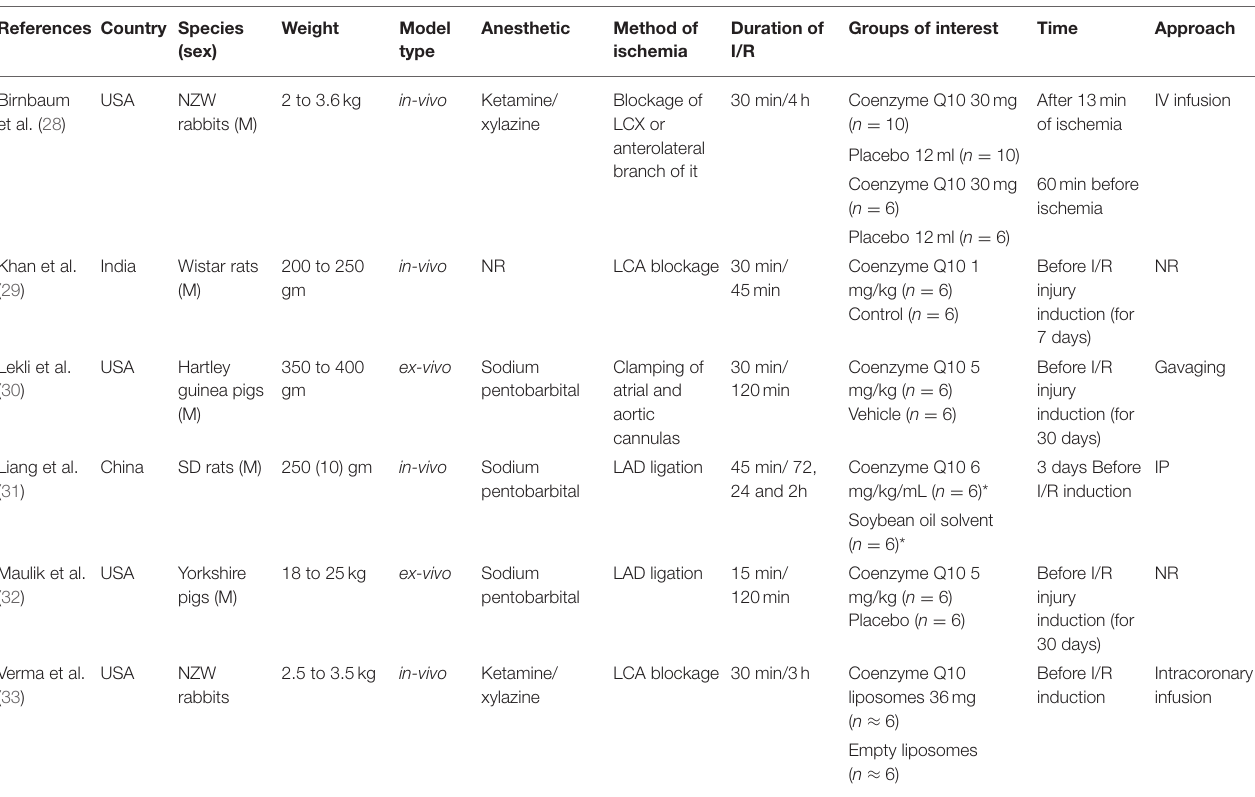
TABLE 1 | Characteristics of the included studies.